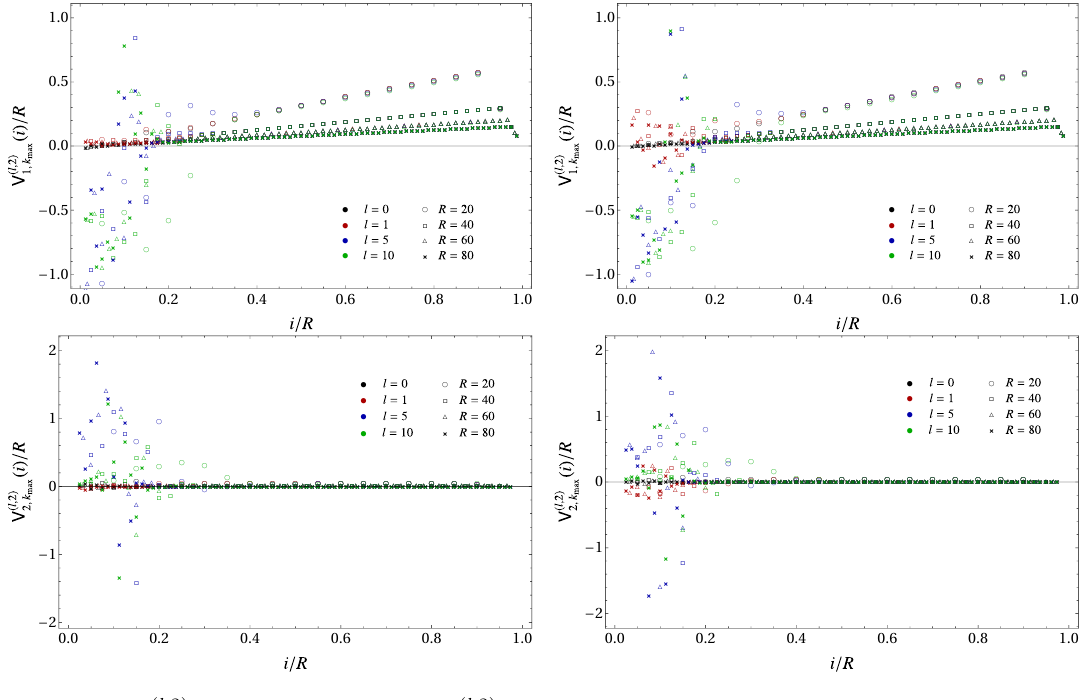
Figure 5. V ( l, 2) /R (top panels) and V ( l, 2) /R (bottom panels), from (3.23) and (3.25) respec- 1 ,k max 2 ,k max tively, when ω = 0 and either d = 2 (left panels) or d = 3 (right panels), for various values of l and R . Here k = R/ 10 for every l max